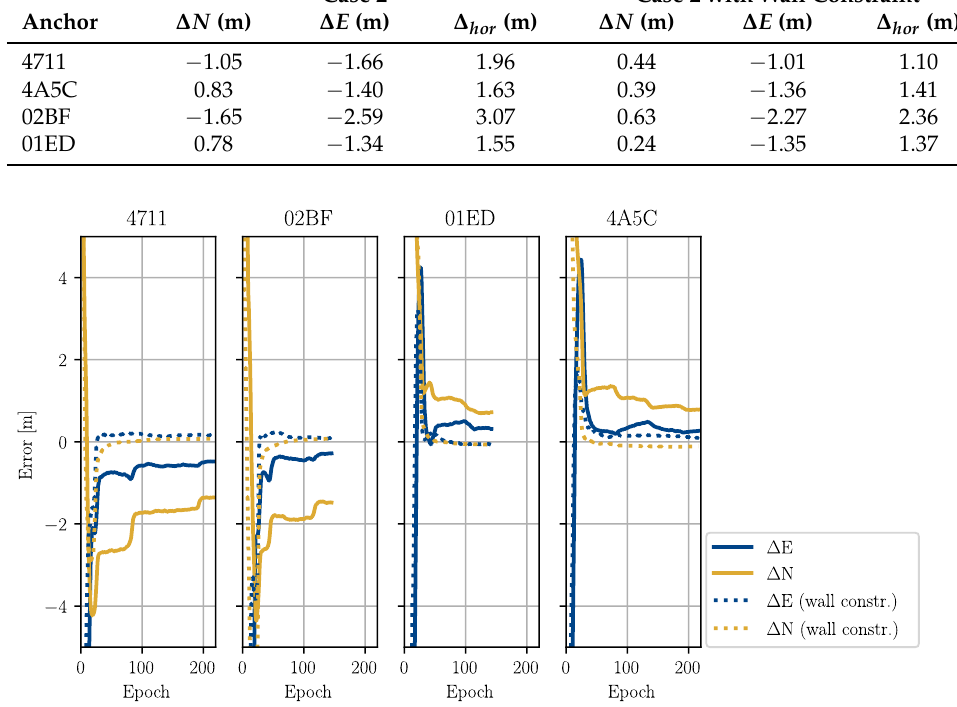
Figure 15. Time series of errors in the anchor position estimates for Case 1 for each anchor, with and without the wall constraint. In each epoch, one range measurement was processed. The number of epochs differs due to the number of available ranges (simulated ranges < 45 m).